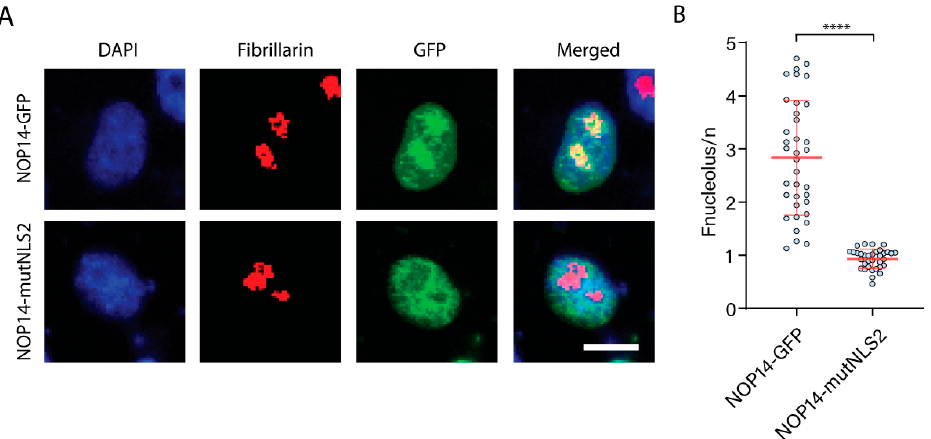
Figure 8. NLS2 plays a role in the nucleolar localization of NOP14. ( A ) Confocal images of HeLa cells transfected with plasmids expressing NOP14-GFP or NOP14-mutNLS2 24 h post-transfection. Samples were prepared for indirect immunofluorescence microscopy using an antibody against fibrillarin (red), and nuclei were stained with DAPI. Scale bar, 10 μ m. ( B ) Quantification of the ratio of nucleolar to nuclear fluorescence (Fnucleolus/n) from the experimental conditions shown in A. Shown are the means ± standard error of the means scored from 50–80 cells for each condition from three independent experiments. (**** p < 0.0001, one-way ANOVA followed by Tukey’s tests).